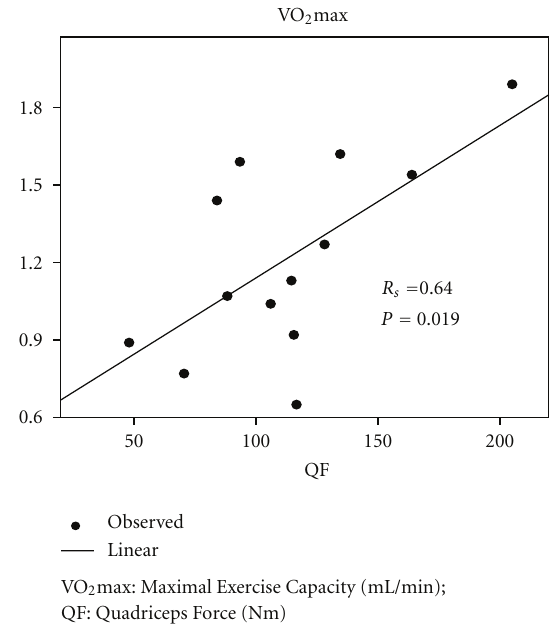
Figure 1: Correlation between maximal exercise capacity and muscle